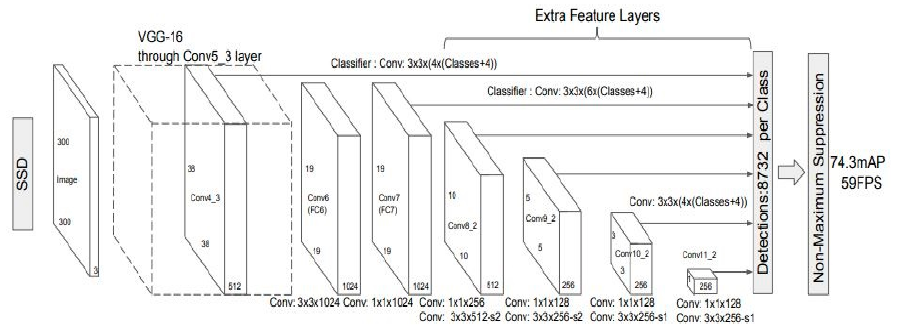
Figure 9. SSD Model (Liu et al.